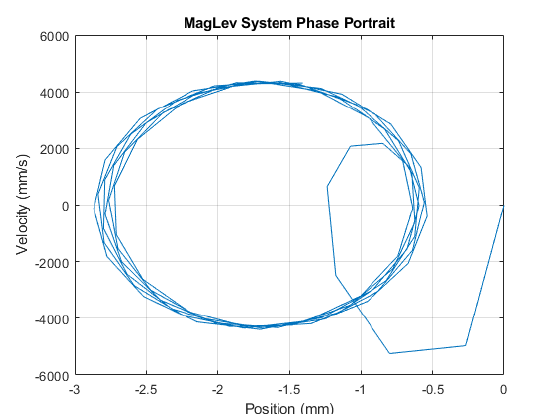
Figure 12. Phase portrait of the Maglev system with a reference sinusoidal wave of 4000 rad/s under Deep Lyapunov Control.